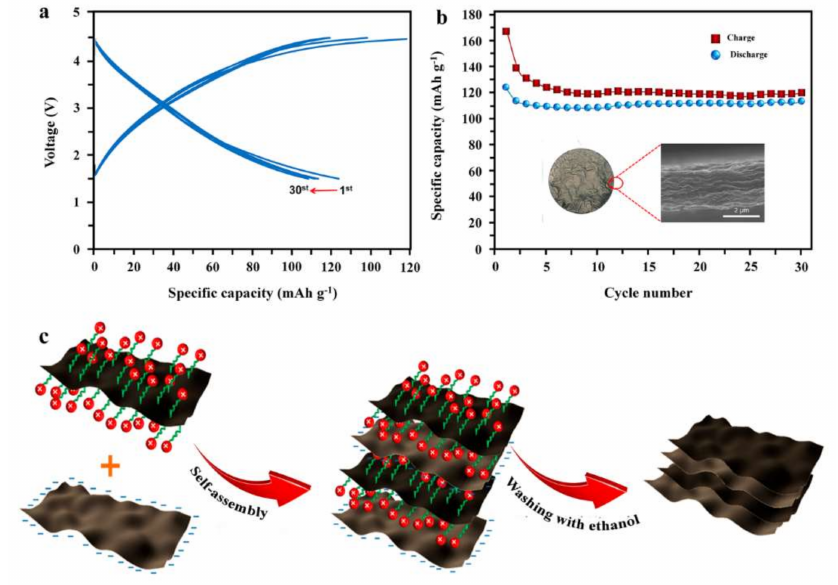
Figure 21. The performances of rGO15 films at 0.137 A g − 1 for 30 cycles; ( a ) charge–discharge curves, ( b ) cyclability of rGO15, and ( c ) schematic illustration of the synthesis of rGO electrode. Adapted and reproduced with permission from Ref. [99]. Copyright 2013 American Chemical Society.